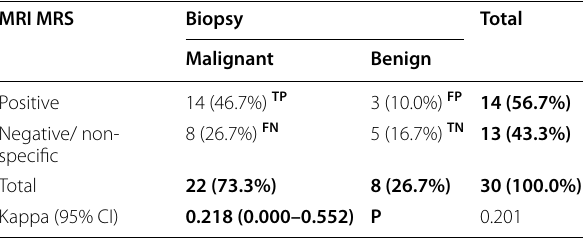
Table 13 Diagnostic characteristics of MRI DCE findings